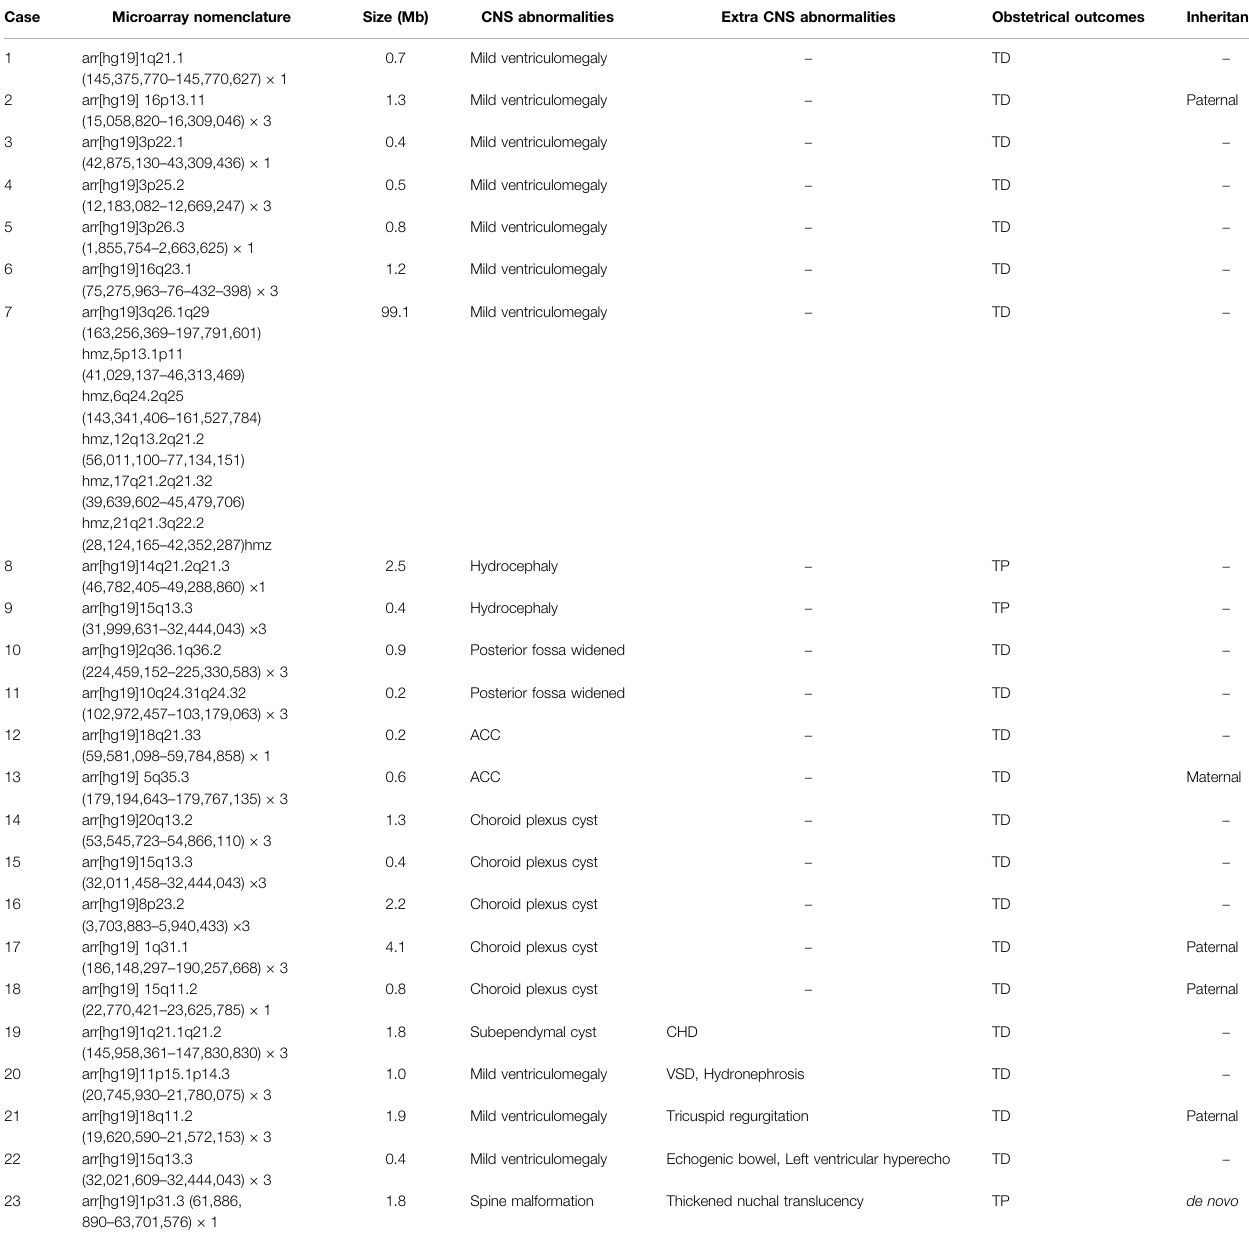
TABLE 4 | The VUS CNVs in fetal CNS